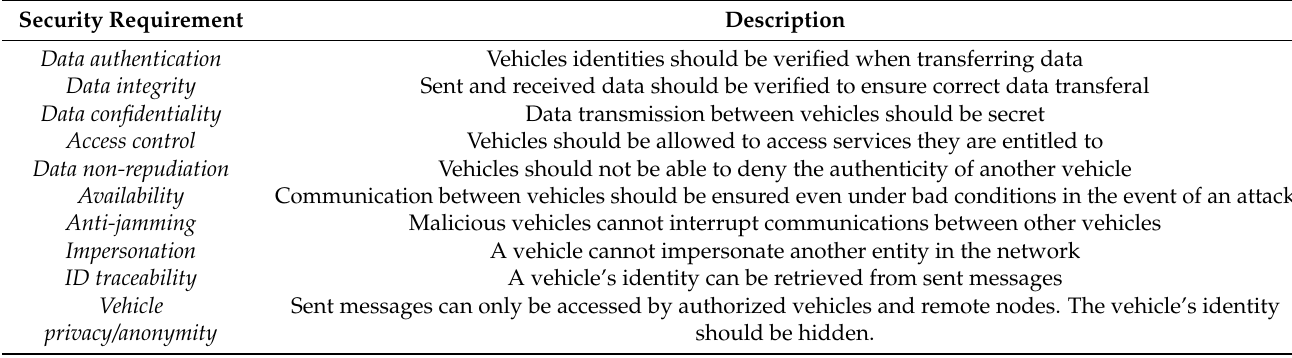
Table 1. Security requirements for IoV